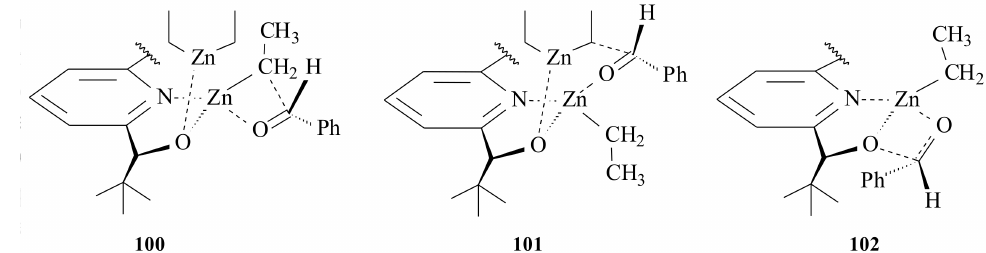
Figure 19. Intermediates proposed for the Zn-catalyzed addition